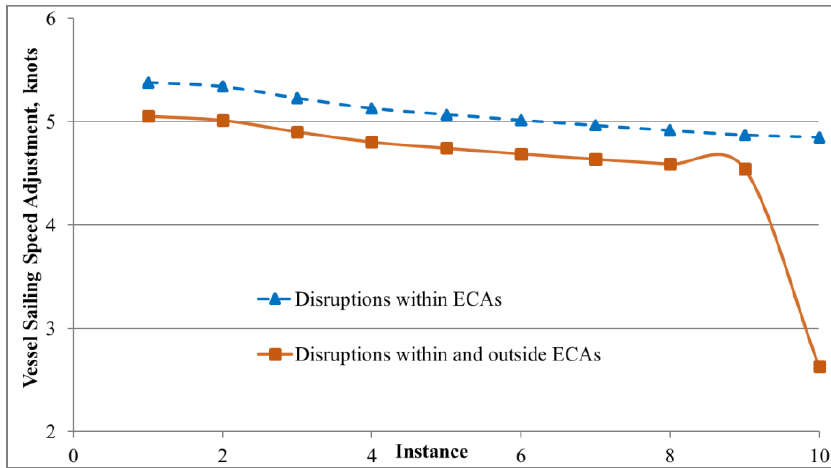
Figure 7. The average vessel sailing speed adjustment for the considered problem instances.